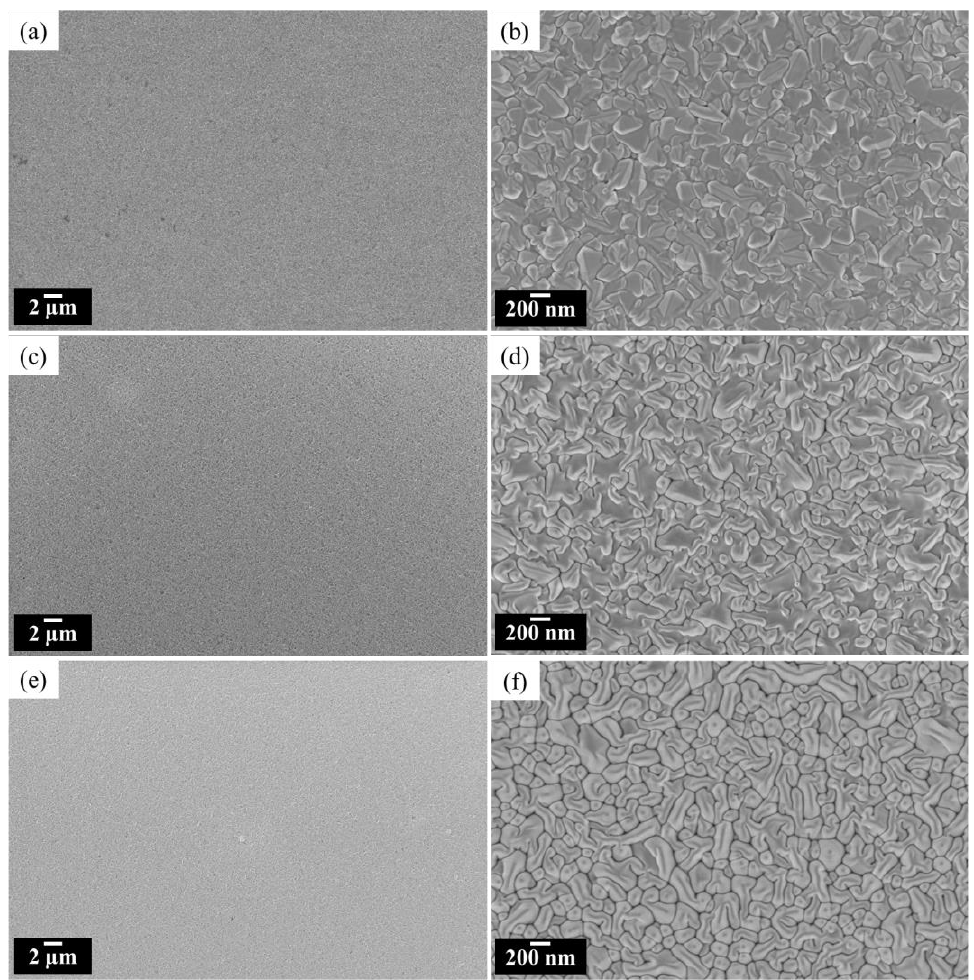
Figure 3. SEM images of the SrTiO 3 -TiO 2 layers after sputtering for ( a , b ) 12 min; ( c , d ) 80 min; and ( e , f ) 220 min.